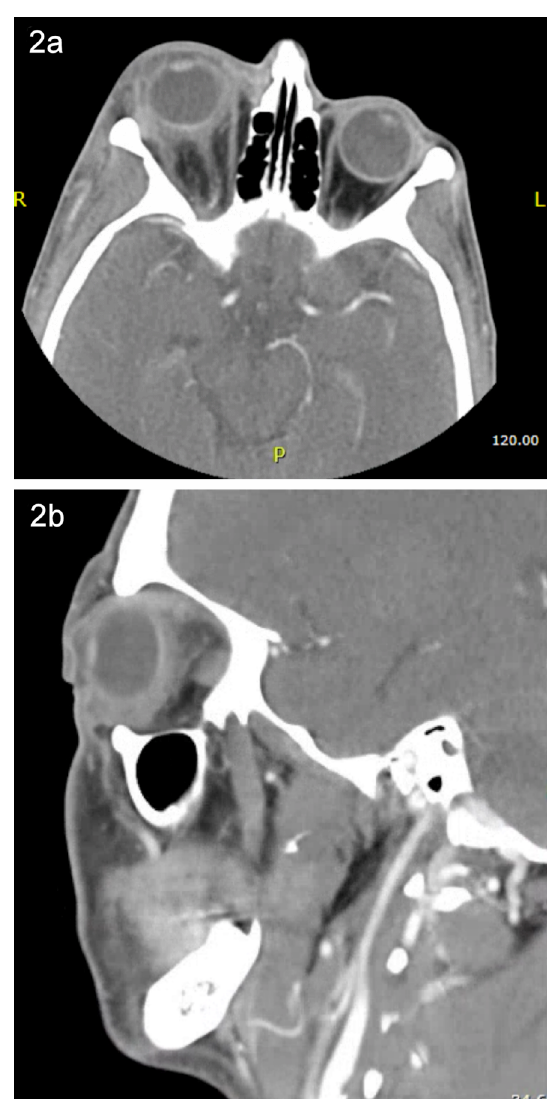
Figure 2: Axial (a) and sagittal (b) computed tomography (CT) post-contrast images showing proptosis of the right eye with orbital fat stranding focused primarily around the globe. There is no evidence of sinus disease or subperiosteal abscess.